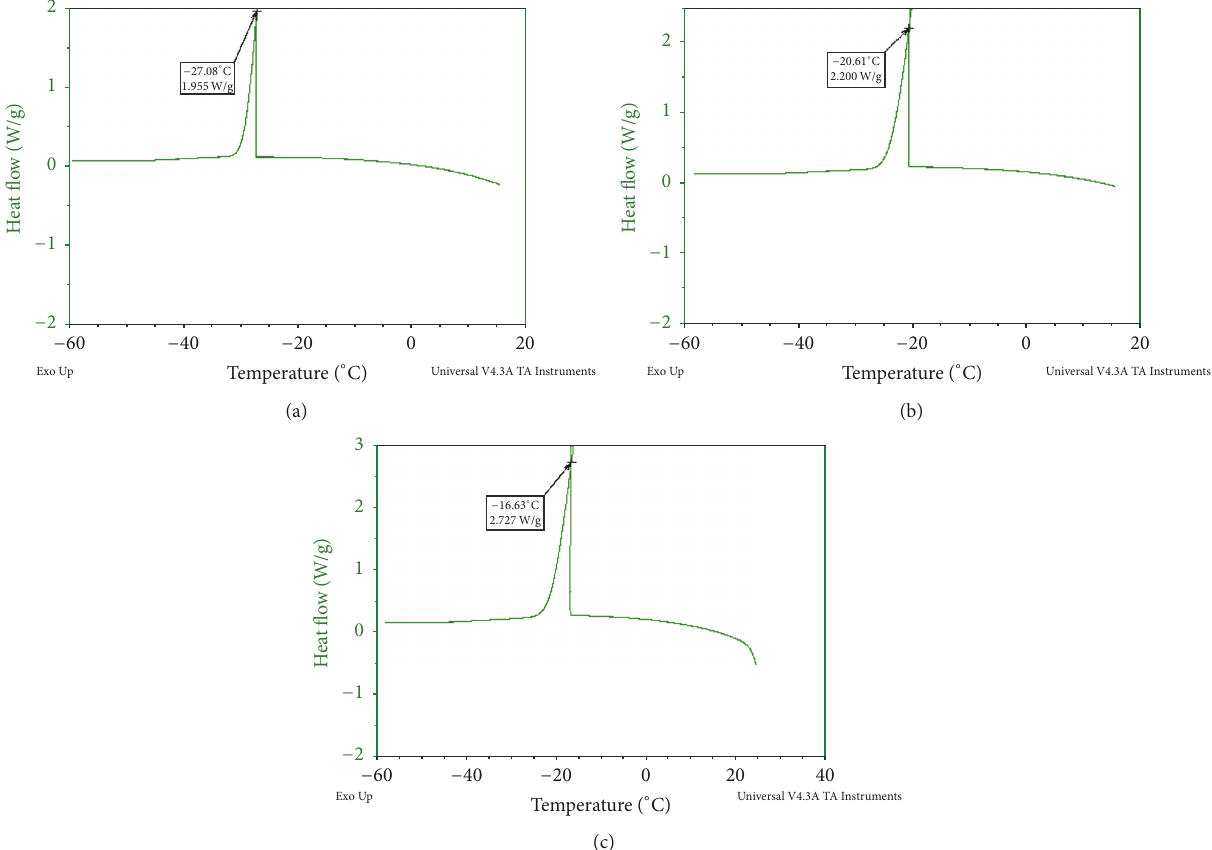
Figure 2: DSC curve for pulp clear juice of three lychees. (a) Feizixiao lychee. (b) Nuomici lychee. (c) Guiwei lychee.